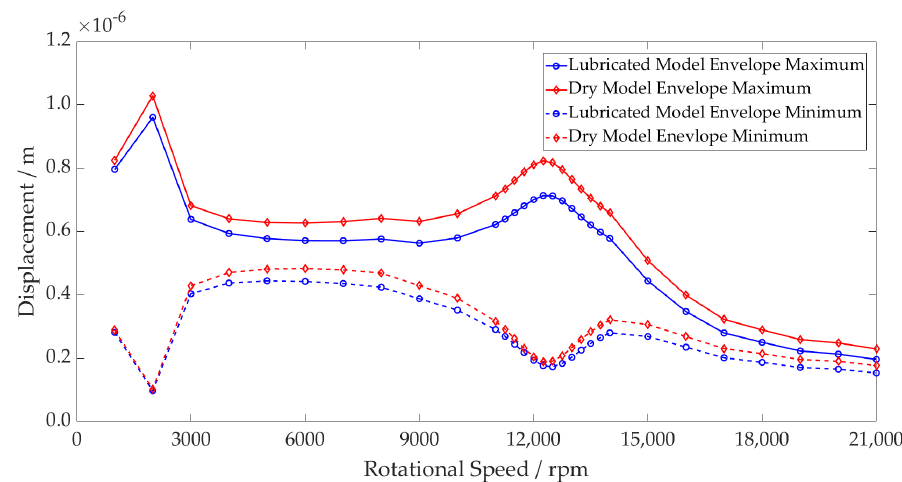
Figure 10. Inner Race Displacement — Dry vs. Lubricated Operating Envelope.